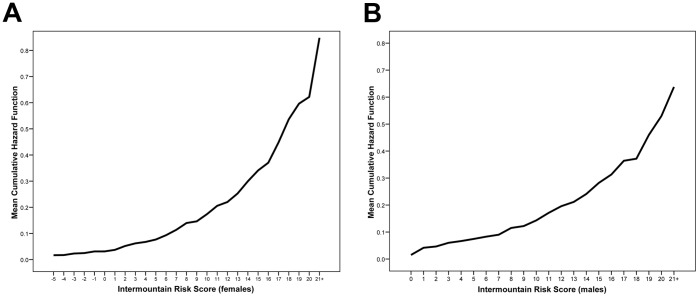
Average cumulative hazard function for mortality from Cox regression for A) females and B) males across each value of the second or follow-up IMRS.